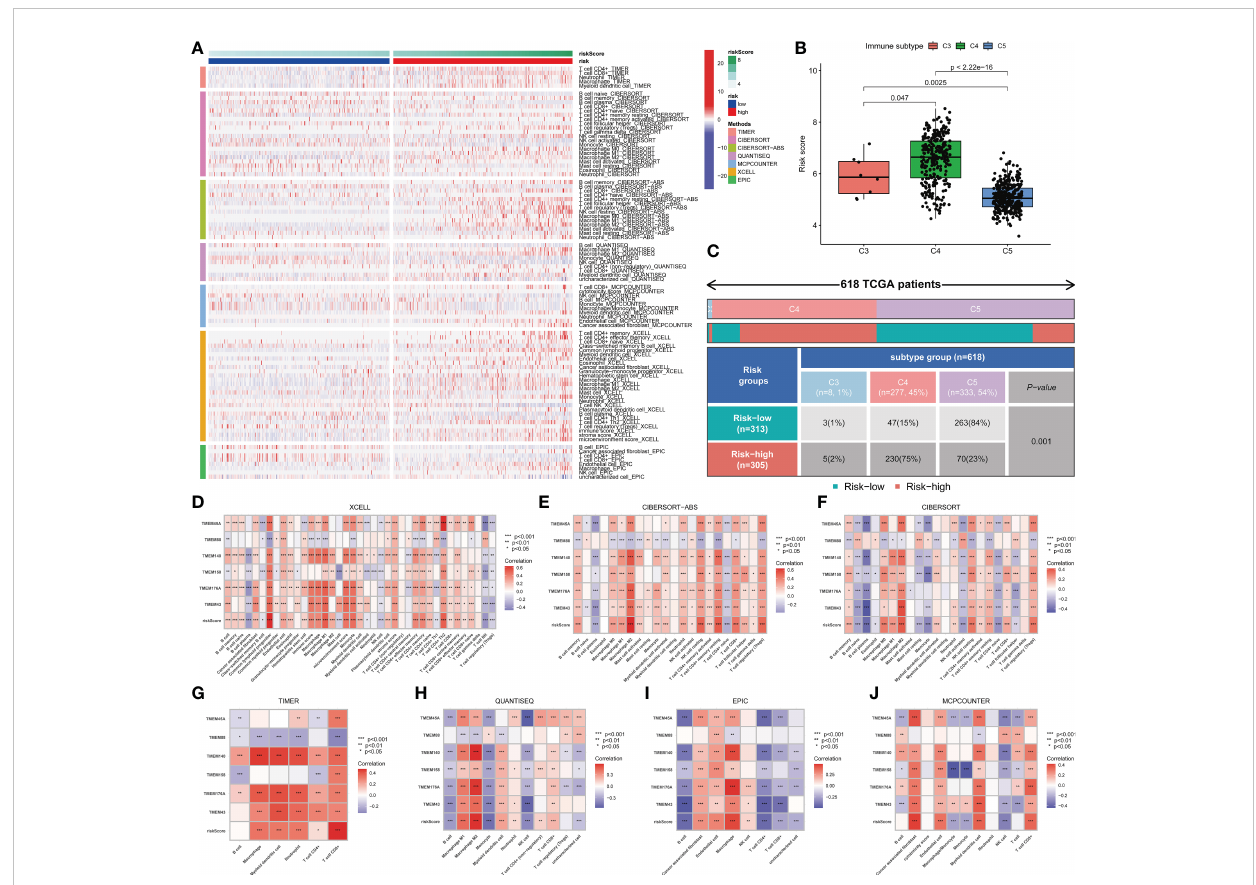
FIGURE 6 Immune cell in fi ltration in glioma. (A) Differences in immune cell in fi ltration between high- and low-risk patients. (B) Three immune types were identi fi ed in the TCGA-glioma dataset, namely In fl ammatory (Immune C3), Lymphocyte Depleted (Immune C4) and Immunologically Quiet (Immune C5). Signi fi cant differences in risk scores were observed between different immune subtypes. (C) The association between risk groups with immune subtypes in the TCGA-Glioma cohort. (D-J) Correlation between risk score, genes in the model and different types of immune cell content based on 7 immune in fi ltration algorithms. Correlation analysis was conducted using Pearson correlation analysis. Differential analyses were conducted using the Wilcoxon